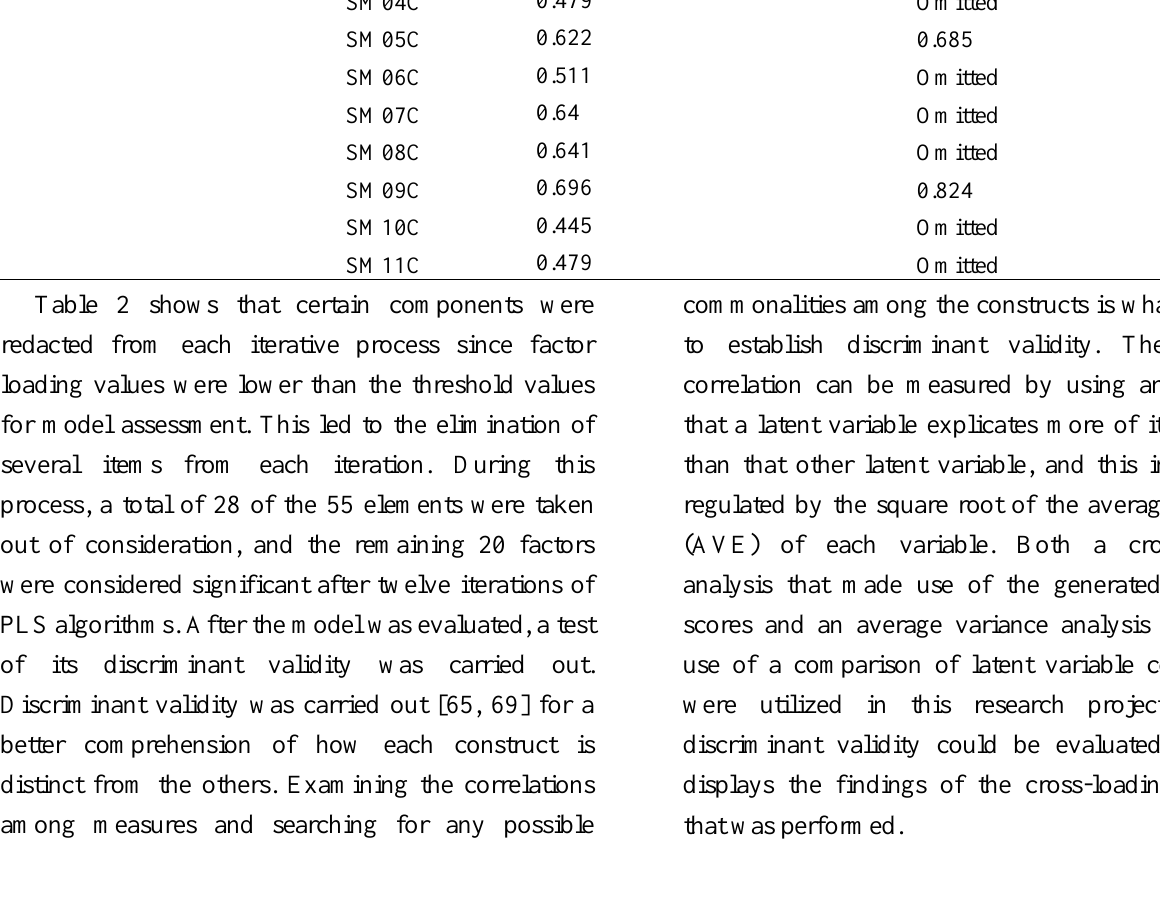
Analysis of cross-loadings of factors Item